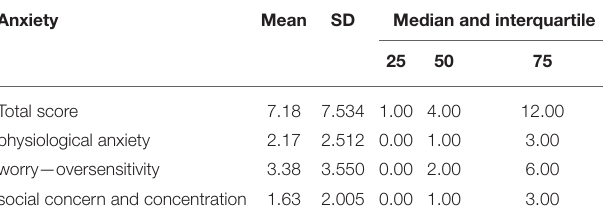
TABLE 3 | Anxiety as measured using the RCMAS.